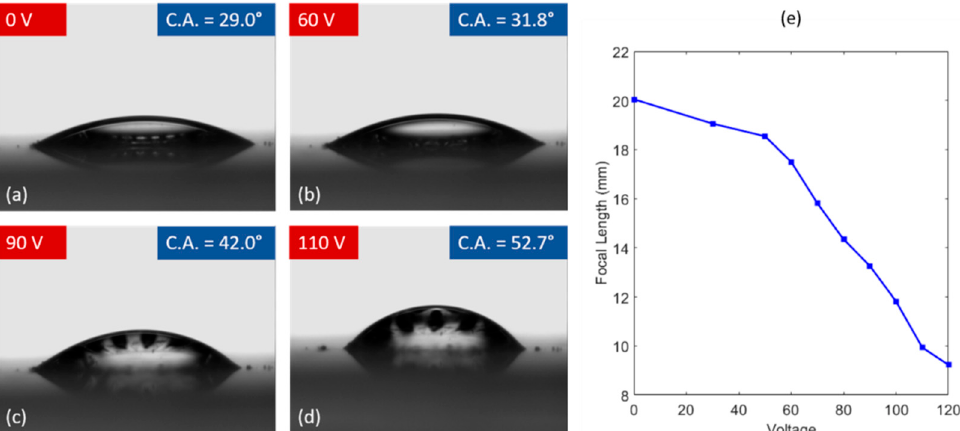
Figure 4. Images of a single lens during actuation, where all applied voltages are AC square waves at 10 kHz, all values peak-to-peak. The dashed green circles have been added to highlight the boundary between the oil droplet and the water that surrounds it. ( a ) The initial, rest state of the lens. With no applied voltage the oil droplet is pinned at the hydrophilic/hydrophobic boundary. ( b ) At 40 V, the oil droplet has begun to be squeezed as the water is attracted toward the underlying electrodes. This squeezing increases steadily with increased applied voltage as seen in ( c ) at 60 V, ( d ) at 80 V, ( e ) at 100 V and finally ( f ) at 140 V.